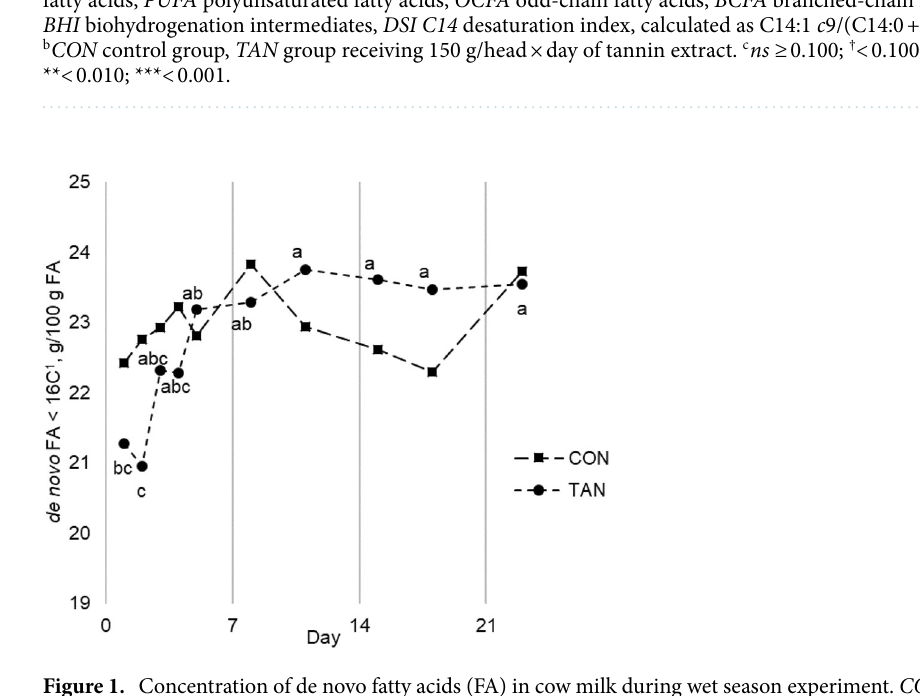
Figure 1. Concentration of de novo fatty acids (FA) in cow milk during wet season experiment. CON control group, TAN group receiving 150 g/head per day of tannin extract. 1 De novo FA < 16C = sum of C4:0. C6:0. C8:0. C10:0. C12:0 and C14:0. a,b,c Points with different letters differ at P < 0.050, within TAN group. There was no difference between points within CON group.